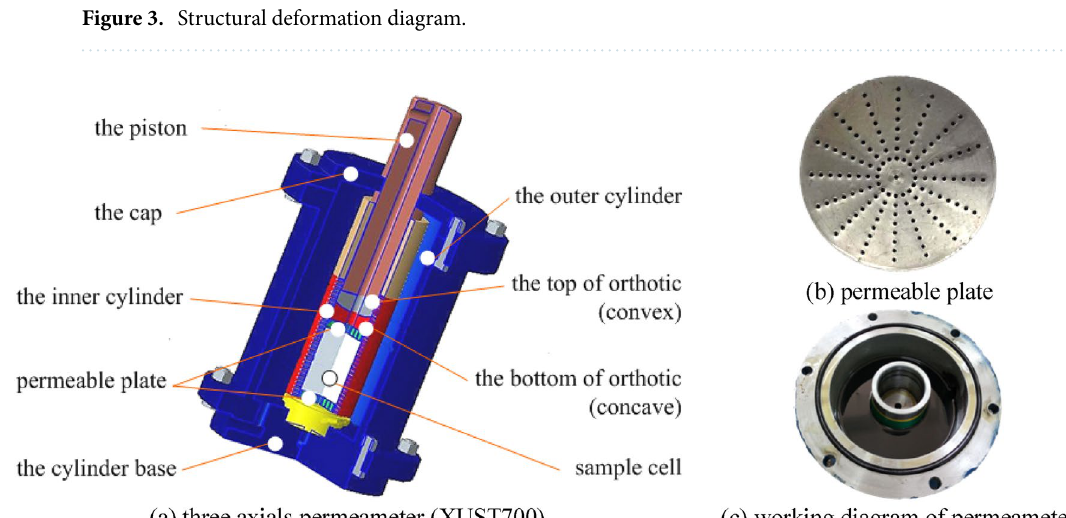
Figure 4. Sample installation